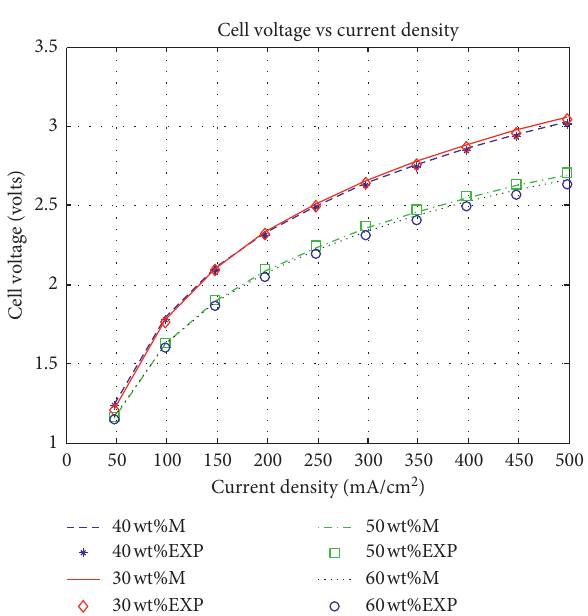
Figure 4: I-V curve for different interelectrode